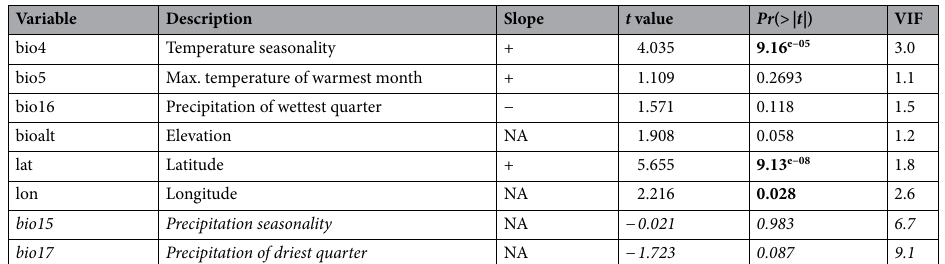
Table 2. Multiple regression model of phenotype–environment associations in hoary bats. The reduced model included six variables (in regular font), of which three showed a significant association with phenotypic variability. Multiple R 2 = 0.585, adjusted R 2 = 0.566; F-statistic = 31.2 on 6 and 133 DF; overall model P < 2.2 e−16 . Estimated variance inflation factors (VIF) for all variables in the reduced model are below 5, indicating low degree of multicollinearity. Two variables in the full model (bio15 and bio17, shown in italics) exceeded the VIF threshold of 5 and were excluded in the reduced analysis due to collinearity. Regression plots for each variable in the reduced model and variance inflation factors estimates are presented in Supplementary Fig.